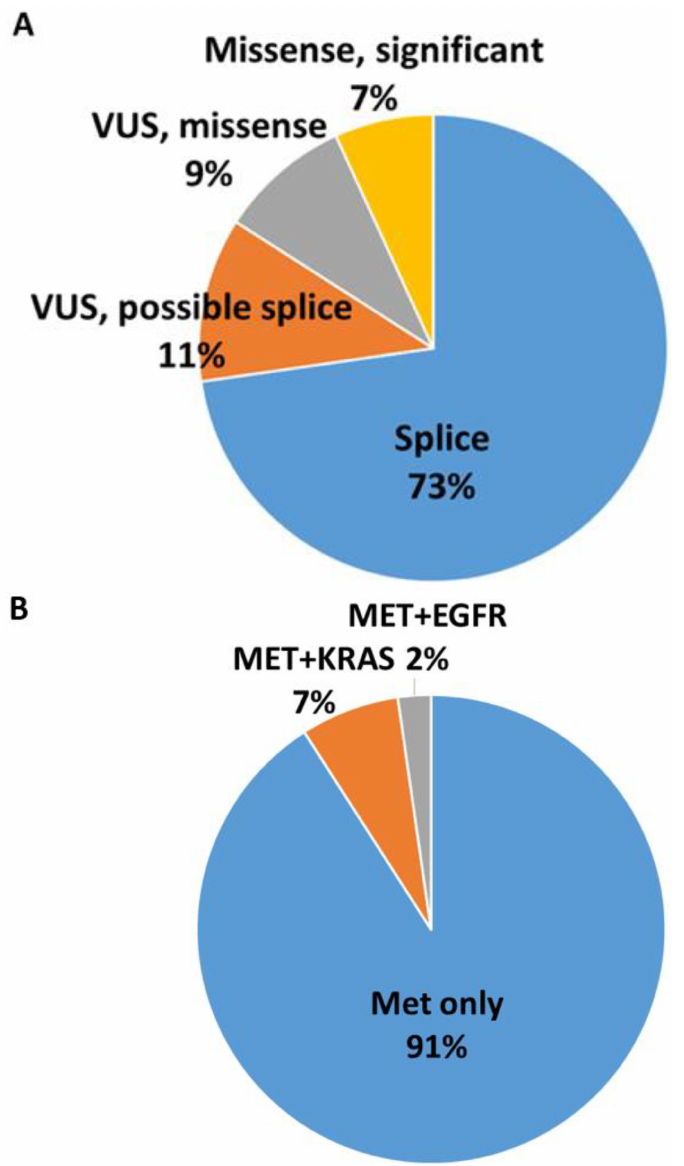
Figure 1. ( A ) MET ex14 variants present in 44 cases: 32 MET exon 14 skipping, 3 significant missense, 9 VUS. Of 9 VUS, 5 were adjacent to the canonical splice site and likely to impact splicing, and 4 were missense variants. ( B ) Four cases had concomitant mutations including 3 with KRAS concomitant mutations and 1 with EGFR concomitant mutations; none were classic exon 14